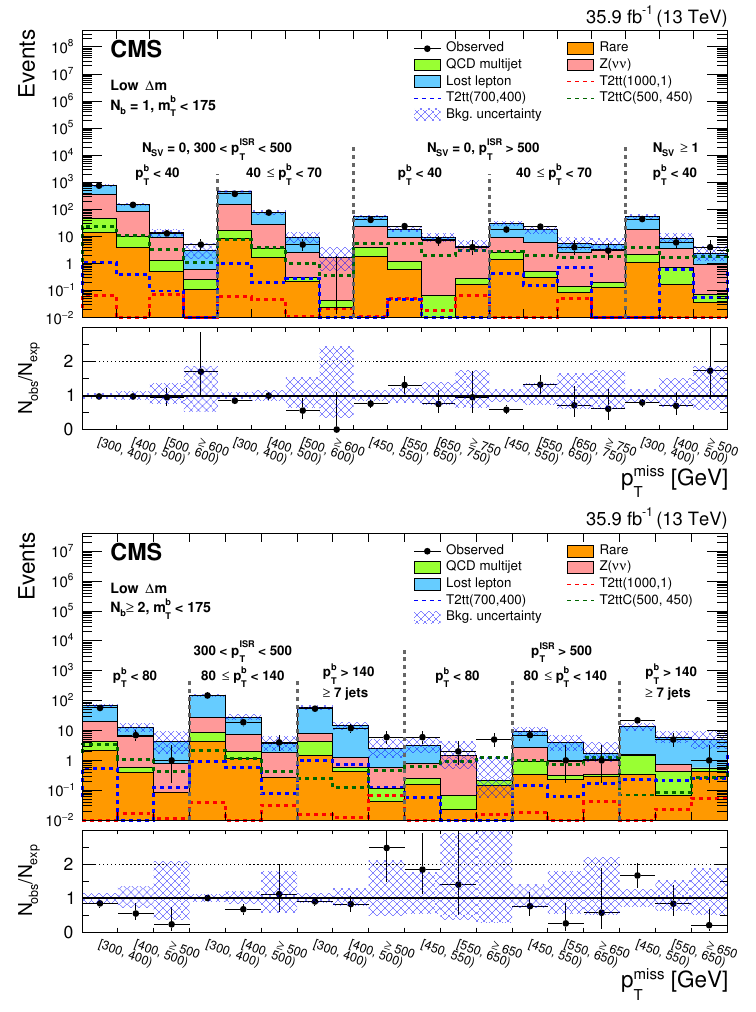
Figure 6 . Observed data events and SM background predictions for the low (cid:1) m search regions with N b = 1 (upper), and N b (cid:21) 2 (lower). Ratios of the observed to SM predicted event counts are shown in the lower panel of each plot. The shaded blue band represents the combined statistical and systematic uncertainties on the SM predictions. The one SR for which the result is not visible in the lower panel is discussed in the text. Units are